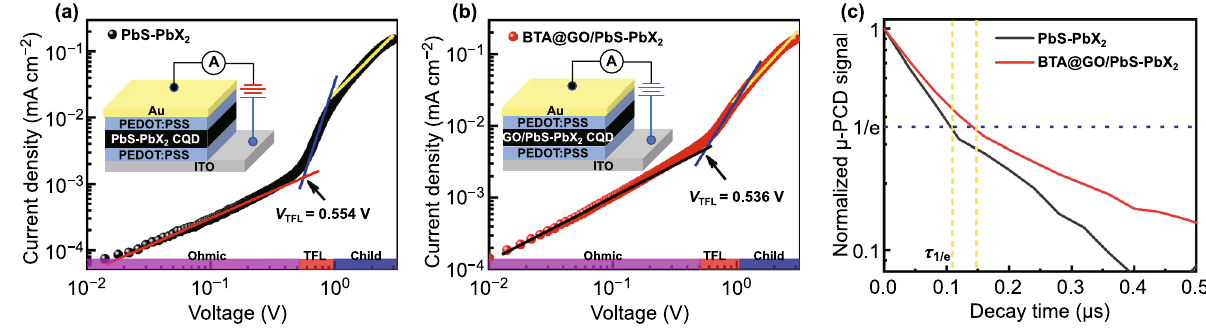
Fig. 4 Dark J – V curves of hole-only devices based on PbS-PbX 2 CQDs film a without and b with BTA@GO. c Normalized μ-PCD decay curves for the PbS-PbX 2 CQDs film and BTA@GO/PbS-PbX 2 hybrid CQDs film. The value of the blue short-dash line is 1/e, and the value of the yellow short-dash line is τ 1/e of carrier decay time, which are approximately 0.11 μs and 0.15 μs for the PbS-PbX 2 CQDs film and BTA@ GO/PbS-PbX 2 hybrid CQDs film,